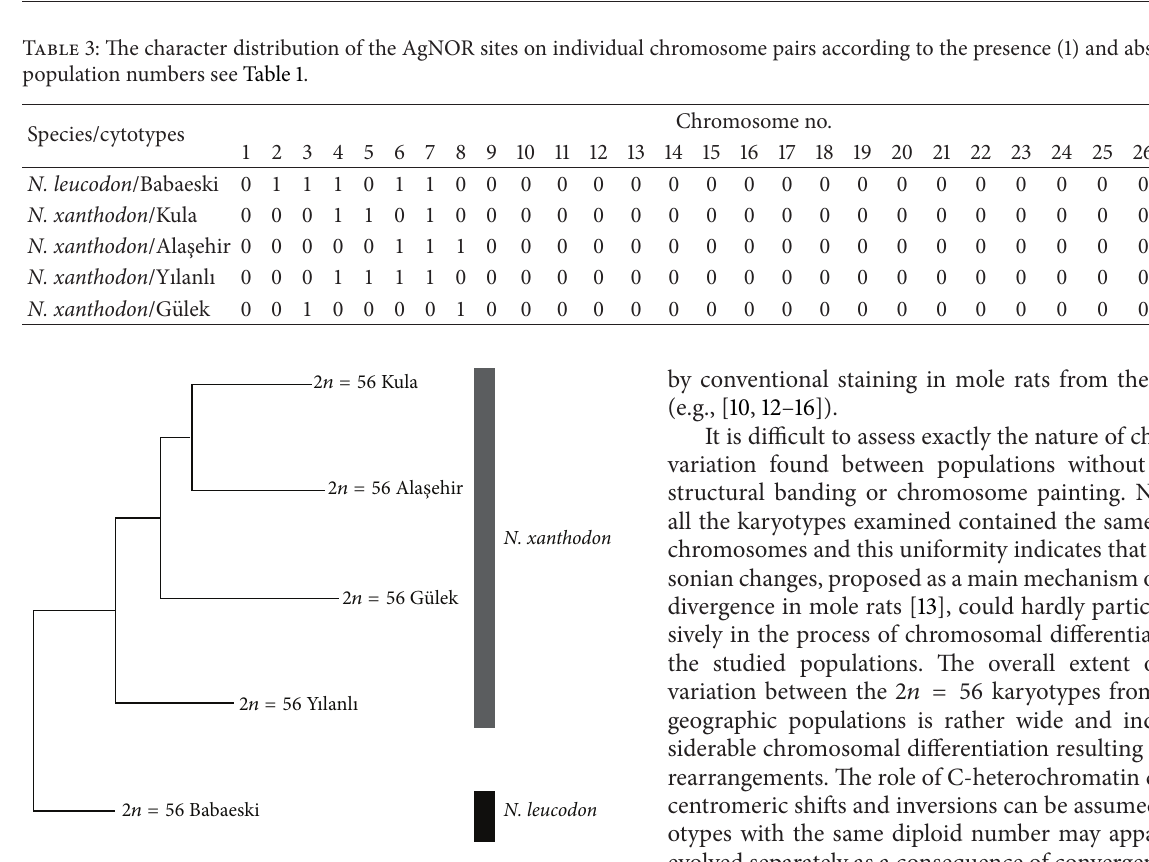
Figure 5: The neighbour-joining tree of the relationships among the studied populations based on the distribution of the C-positive bands and AgNOR sites on individual chromosome